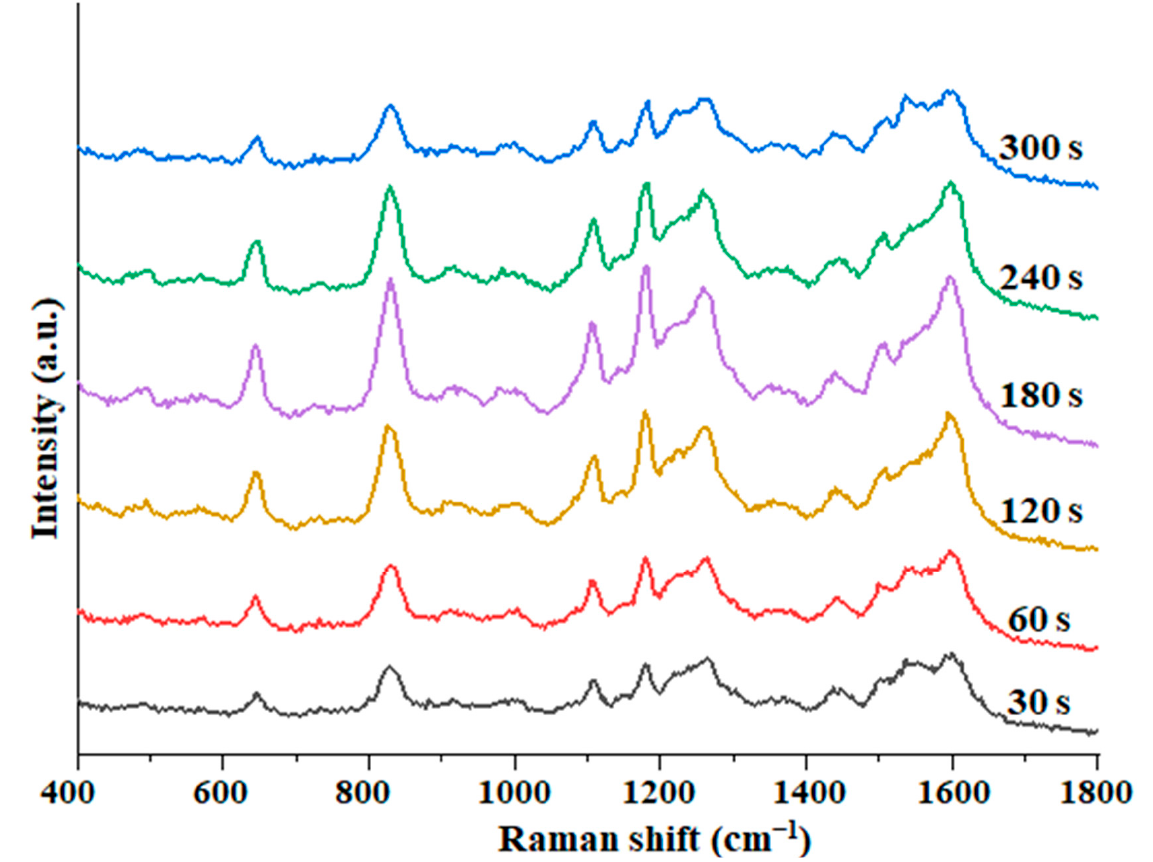
Figure 4. SERS spectra of BPA in methanol solution at different adsorption times.